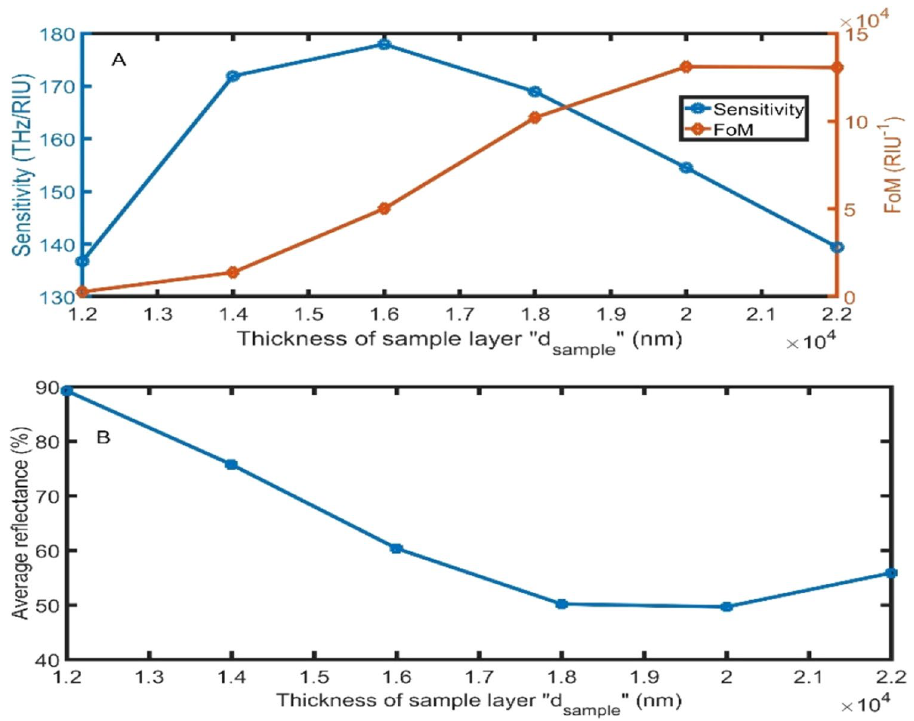
Figure 4. The (A) sensitivity and FoM, and (B) average reflectance of the proposed sensor as a function of the sample layer thickness by changing the sample refractive index from 1.00 to 1.01 at 80°.